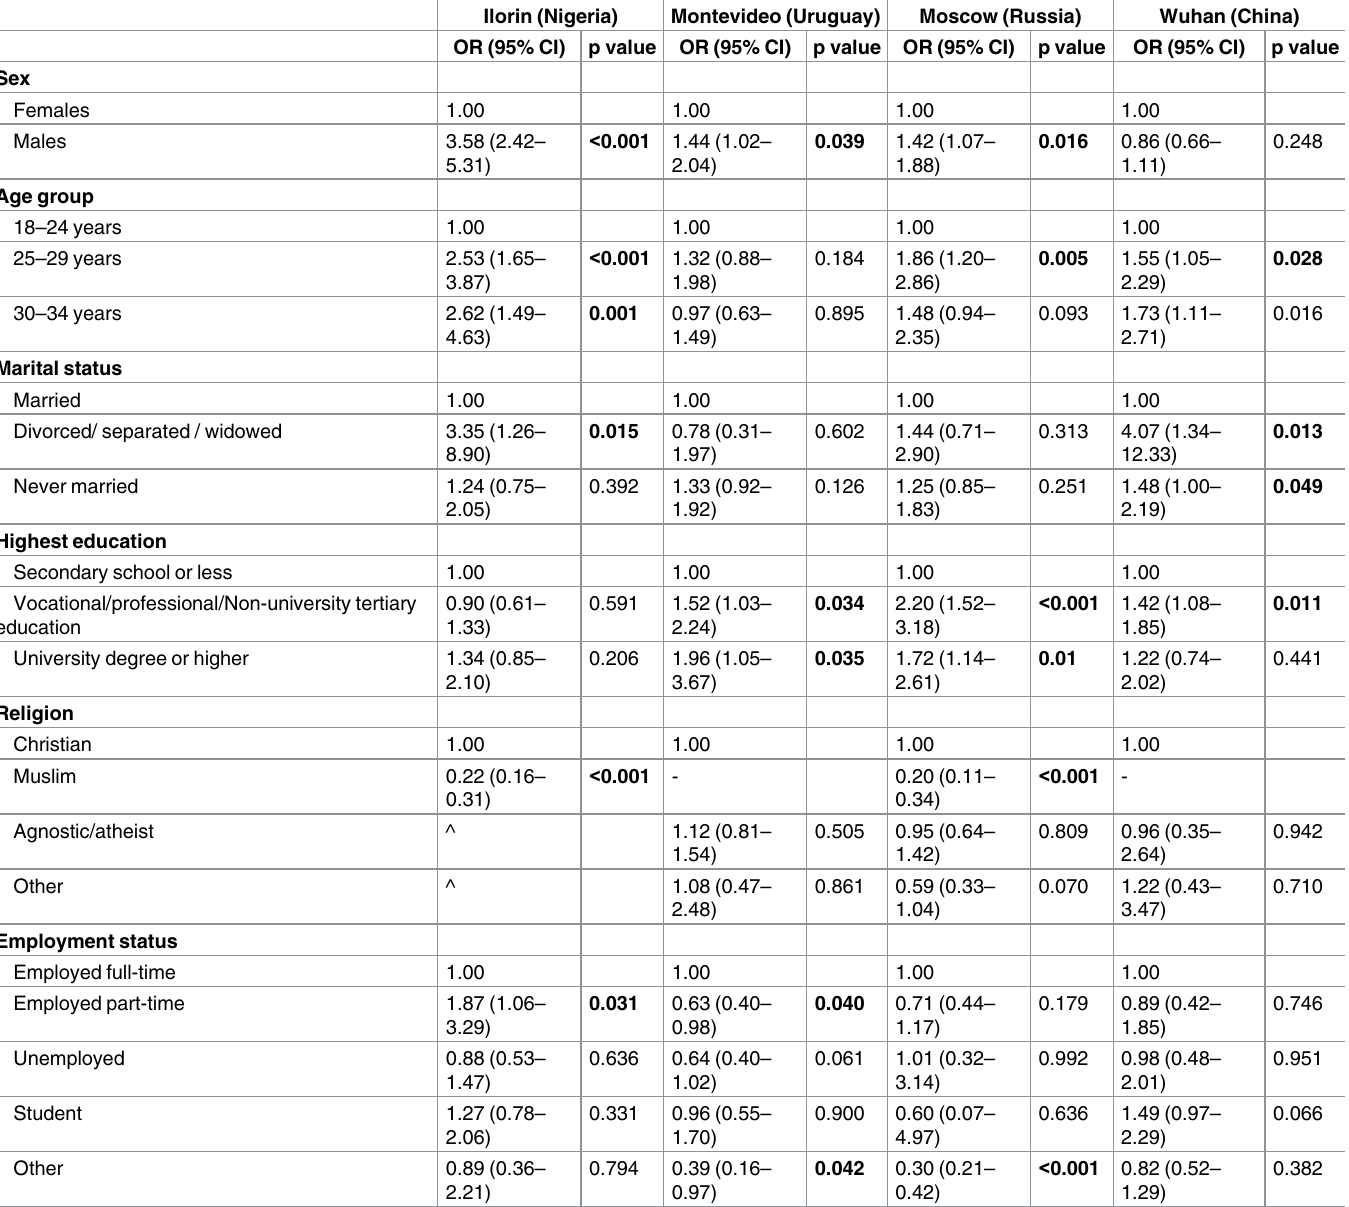
Table 6. Adjusted odds ratios (OR) for current drinkers by city/country a